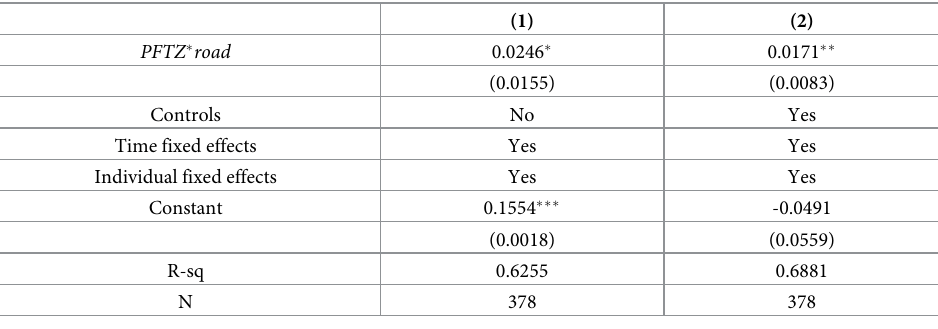
Table 11. Regression results of policy linkage